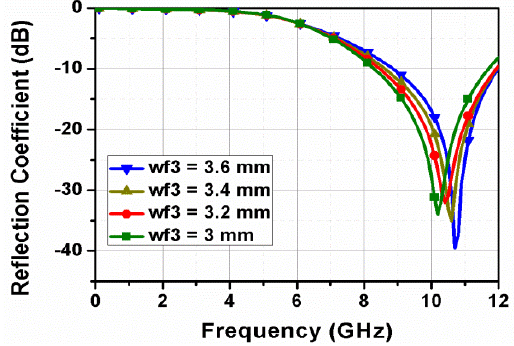
Figure 16 . Reflection coefficient of the antenna linked with port 10 for different values of wf3 .